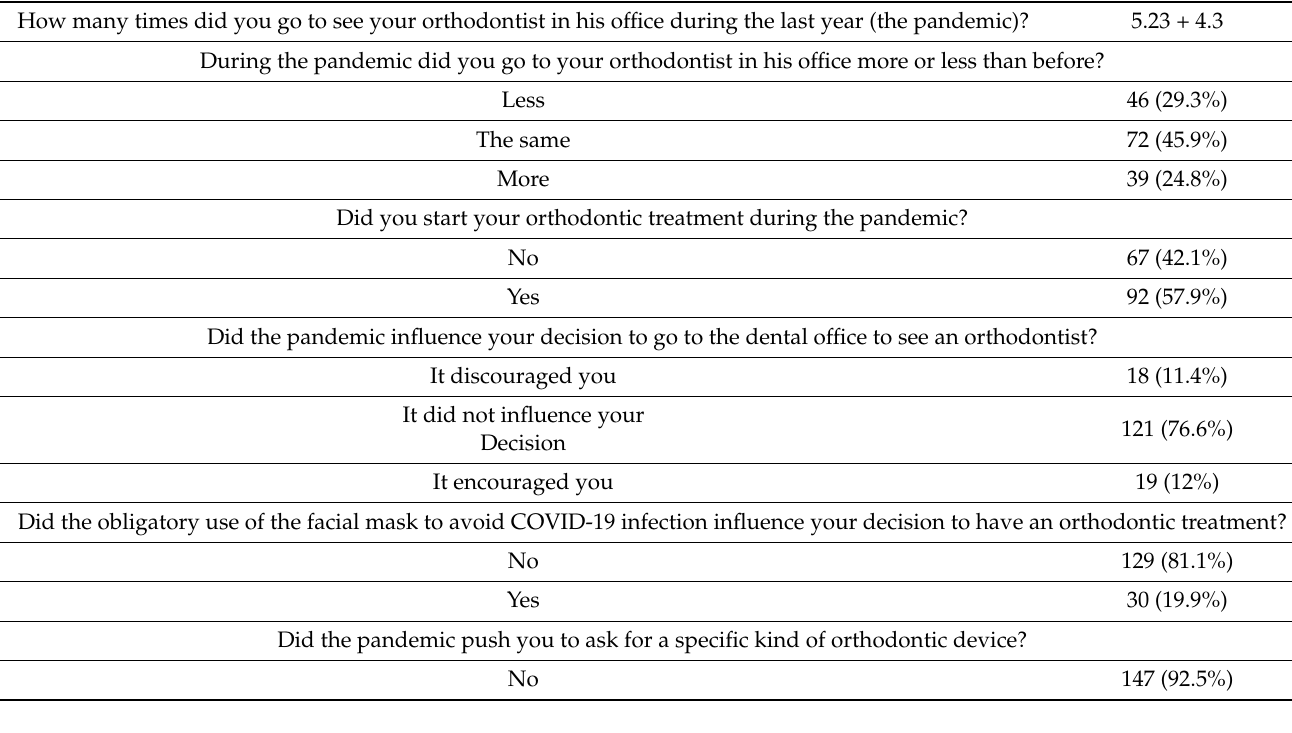
Table 2. Questionnaire answers. N ◦ of visits is expressed as mean ± SD, discrete answers are expressed as absolute (percentage).